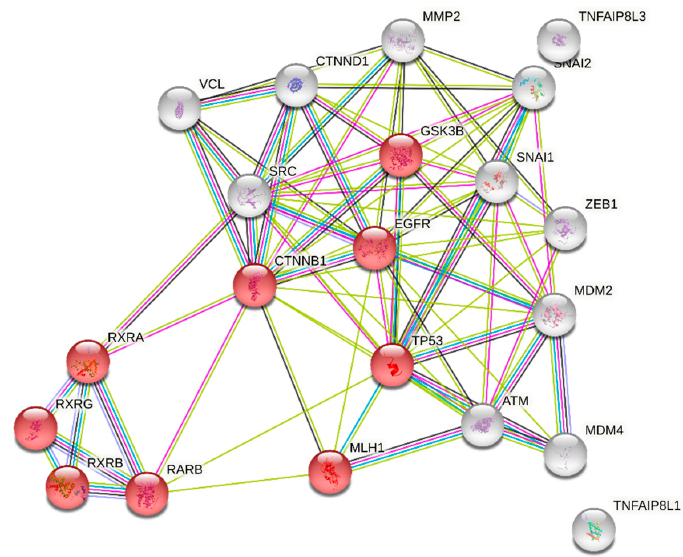
Figure 6. PG II-related protein-protein interaction network generated using STRING. The network is made up of the 21 significant genes (Benjamin corrected p < 0.05) reported in Table 5. Colored nodes indicated the first choice of interactors.